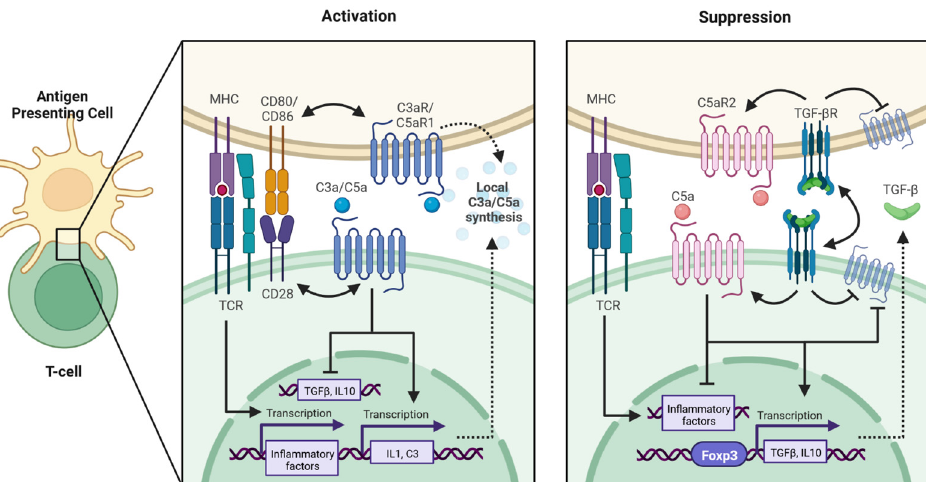
Figure 7. Complement anaphylatoxin signaling in T cell activation and suppression. Activation: Antigen presenting cells interact with T cells via MHC-TCR and CD80/86-CD28 complexes to activate signaling cascades that lead to expression of T cell inflammatory factors. Ligation of anaphylatoxin receptors C3aR and C5aR contribute to effector T cell activation by encouraging transcription of inflammatory cytokines such as IL1, inducing expression of C3, and by suppressing the immune suppressant factors TGF- β and IL-10. Suppression: When anaphylatoxin levels are diminished, C5aR2 sequesters C5a binding, inhibiting activation of the pro-inflammatory factors and allowing for expression of TGF- β and IL-10, which suppress effector immune response. This figure was created with Bio Render. Table 2. Cellular expression of complement inhibitors, factors, and receptors.